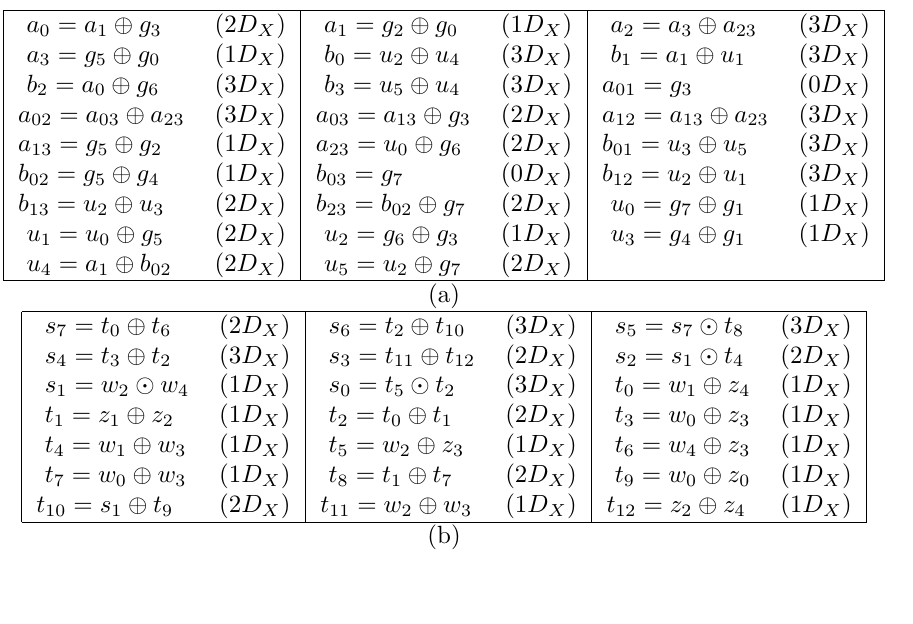
Table 4: Fast implementation of transformations in Figure 2: (a) Computation of g 20 = T in × g in (15) for the input transformation. (b) Computation of s = ( T out × f 10 ) ⊕ h in (16) for the output